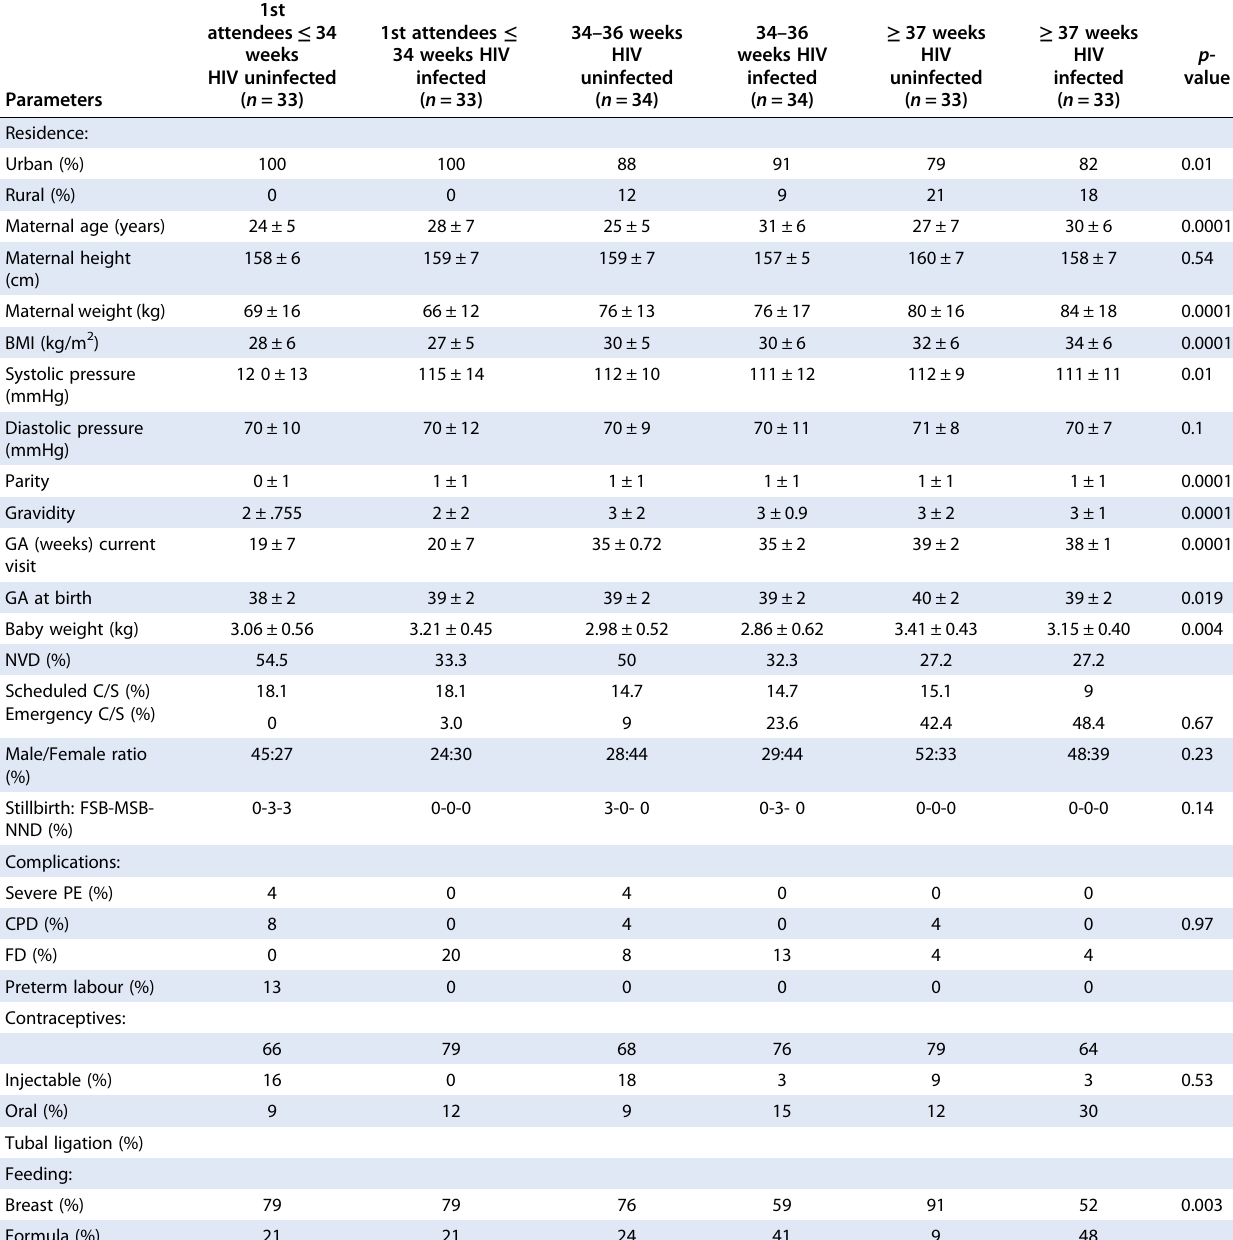
Table 1: Clinical and demographic data of all study